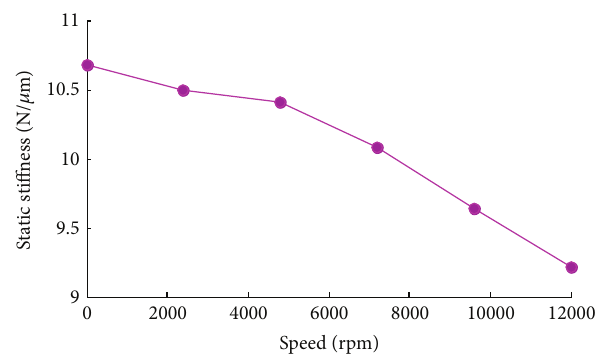
Figure 14: Static stiffness at different